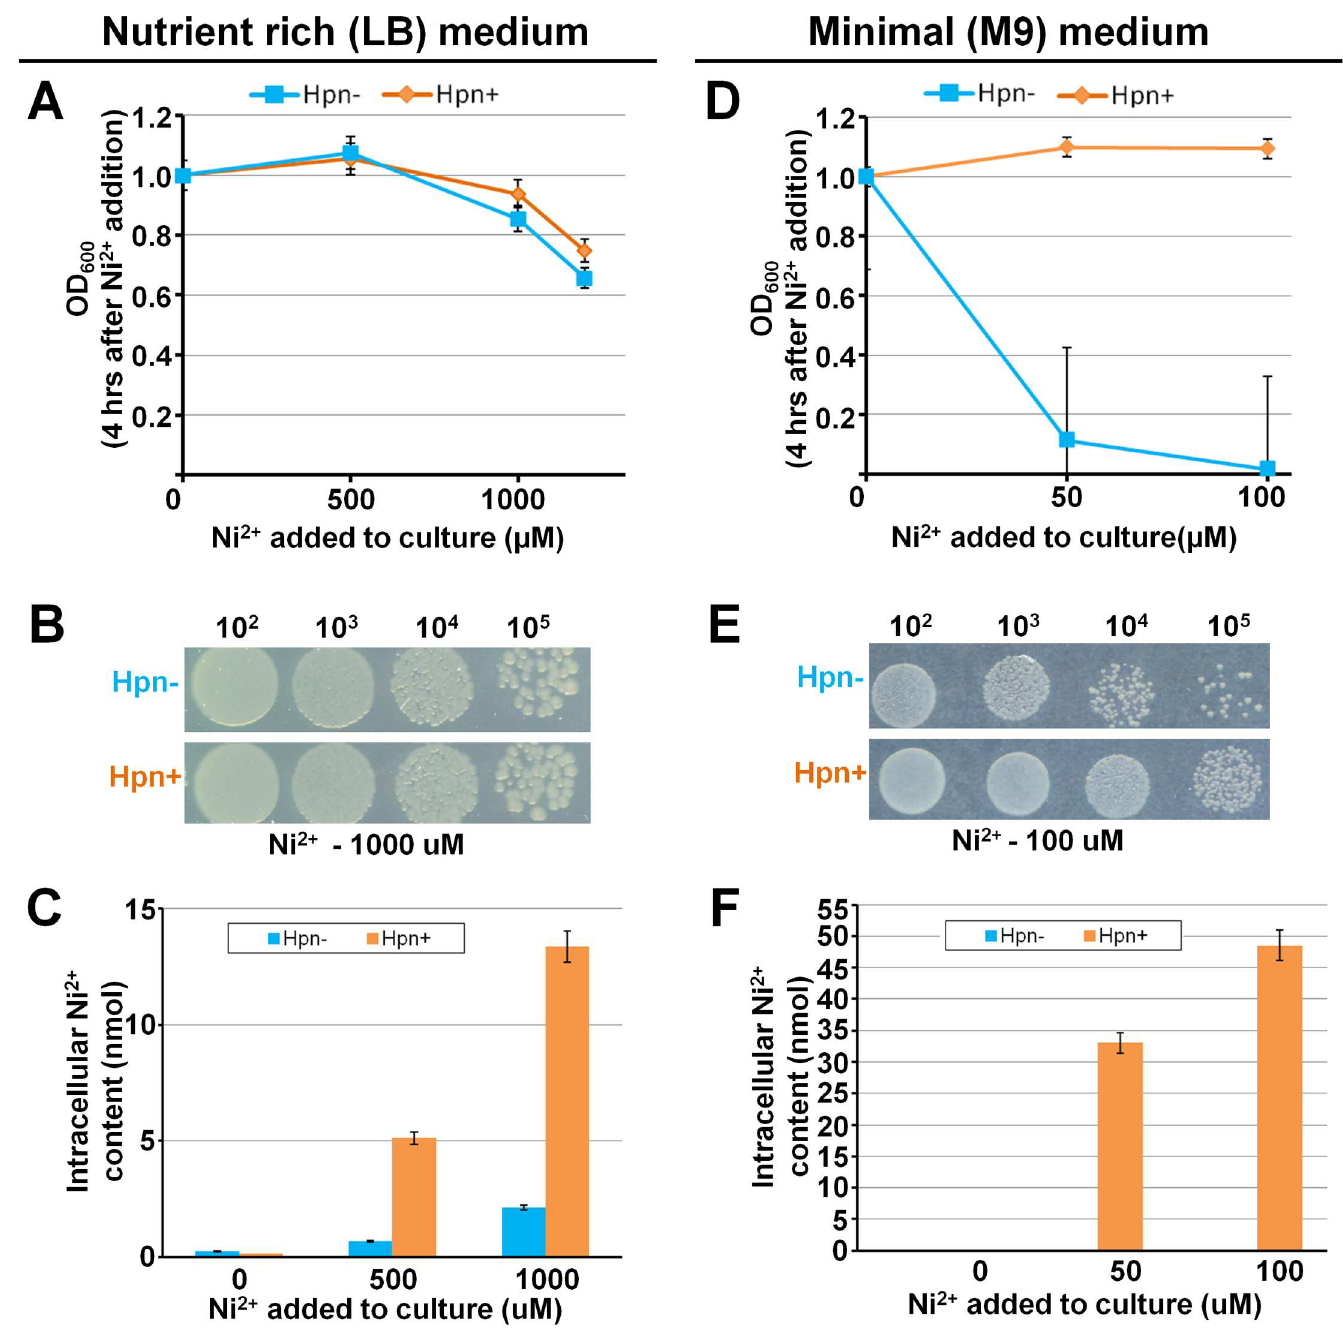
Fig 6. Ni 2+ tolerance, cell survival, and accumulation in Hpn-expressing E . coli . Effect of Ni 2+ on growth of E . coli in Luria-Bertani (LB) (panelA) and M9 medium (panelD). Growth curve was plotted in terms of opticaldensity (OD) against amount of Ni 2+ added to culture. Cell survival under Ni 2+ stress analyzedby dots blot as shown in panel B (LB) and E (M9). Panel C (LB) and F (M9) represent the intracellular Ni 2+ content in E . coli expressing hpn gene compareto that of without hpn